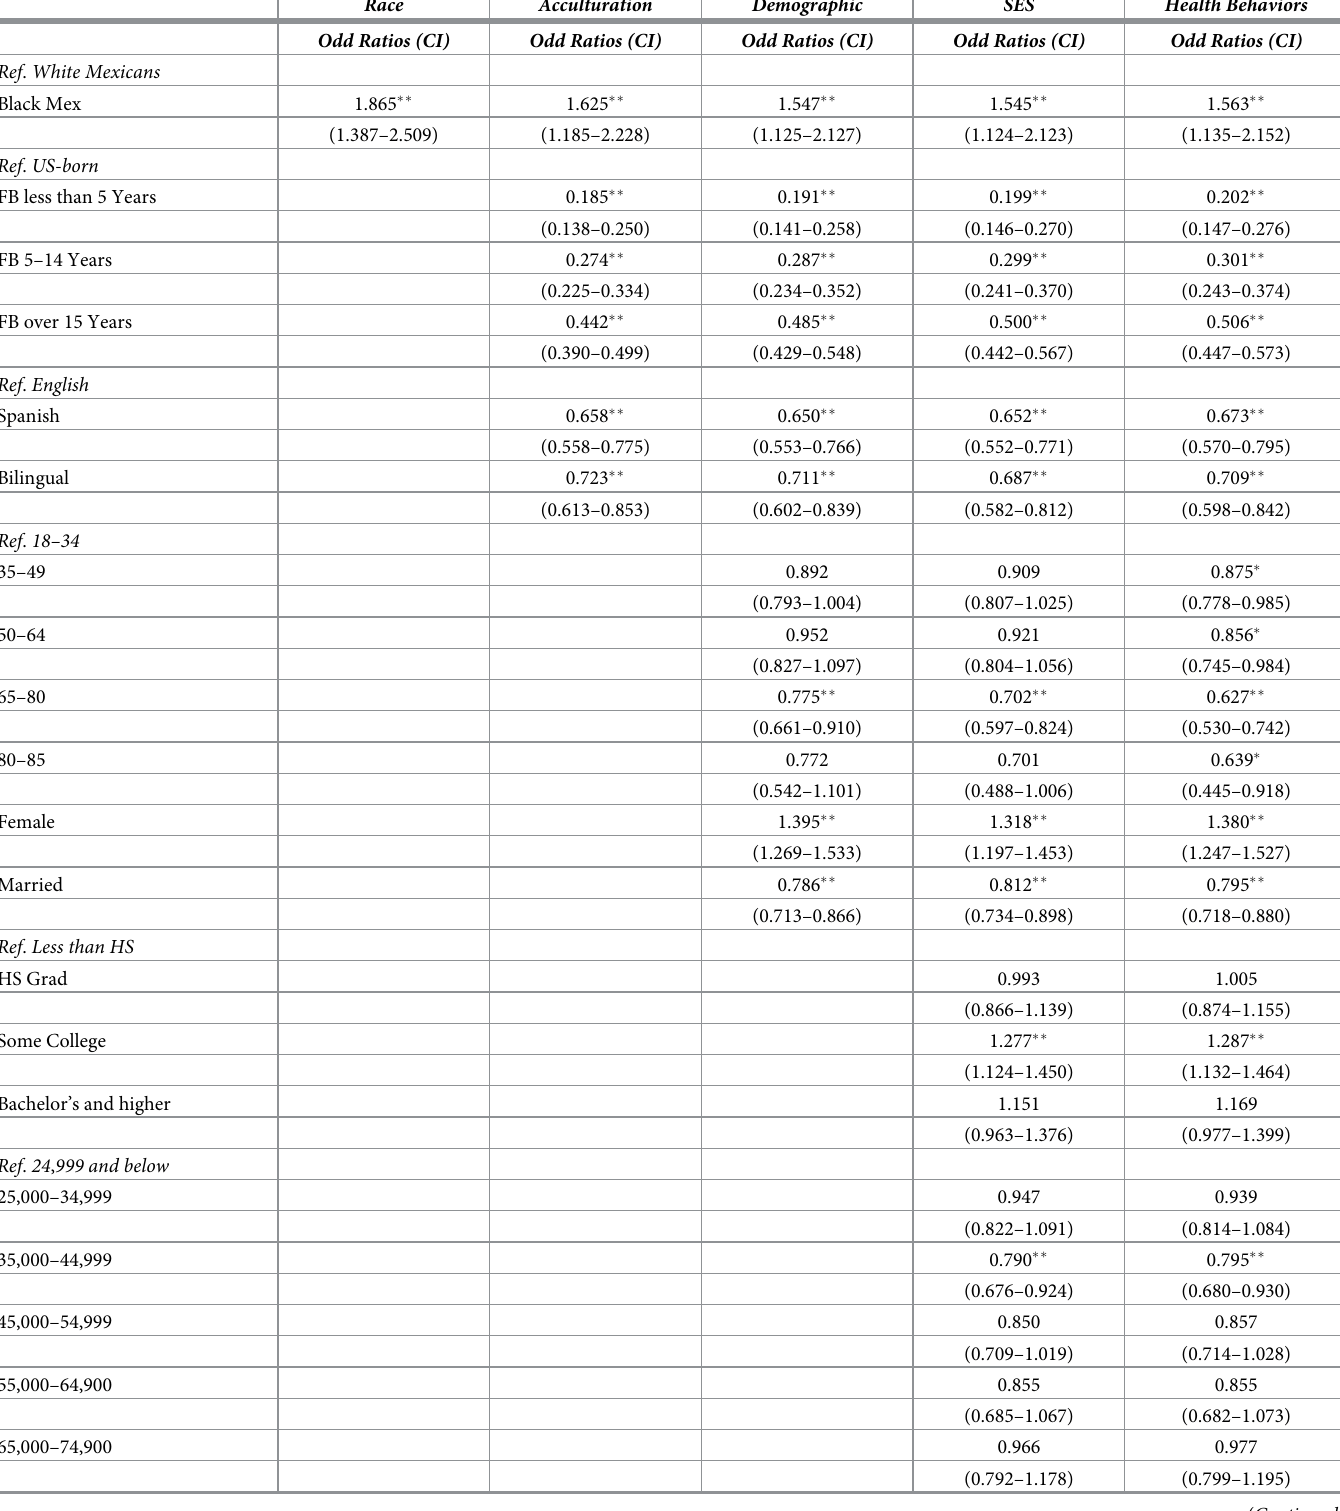
Table 3. Logistic models of asthma comparing White and Black